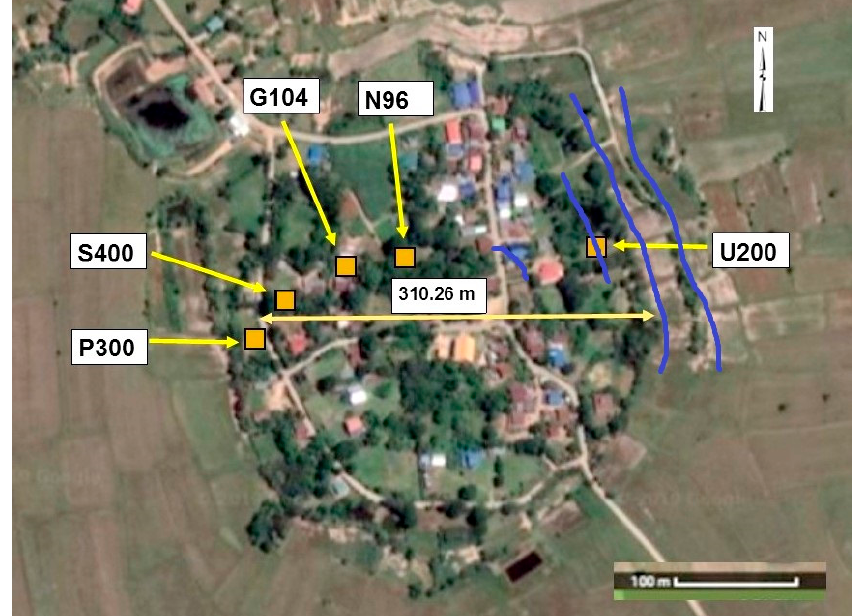
Figure 2. Google map view of the moated settlement of Ban Non Wat and distribution of excavation pits across the moated settlement. Studied samples are from the excavation squares of P300, S400, G104, N96, and U200. Blue lines in right side of the image indicate the channel features.